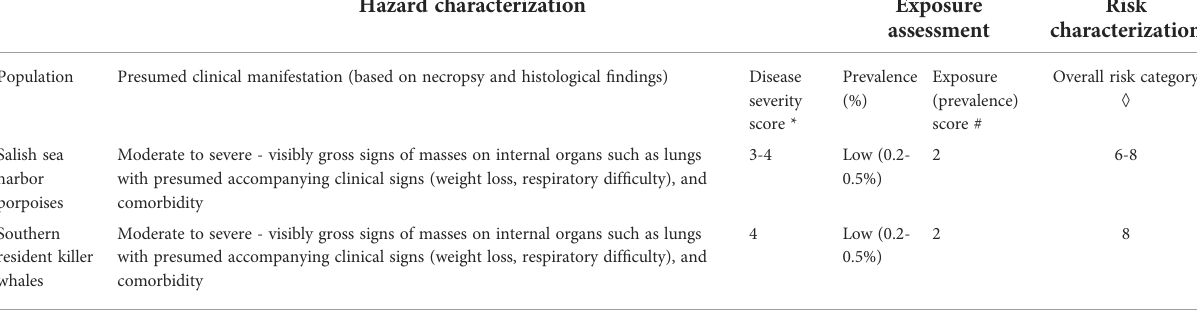
TABLE 4 Overall risk characterization score for harbor porpoise in the Salish Sea and southern resident killer whales, for